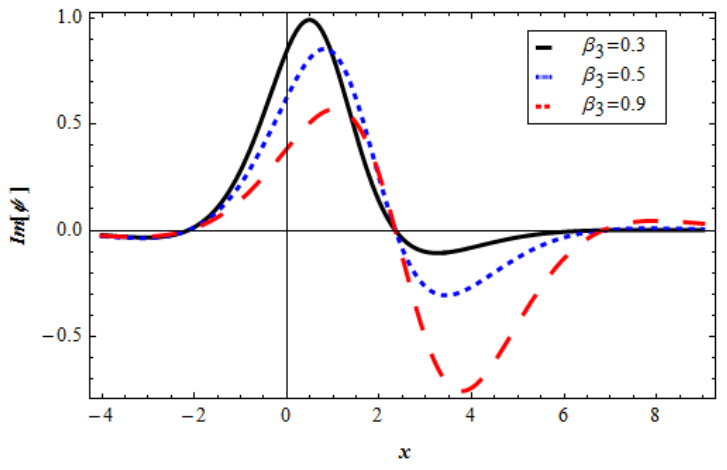
Figure 17. Change of solution (14) with z , t , β 3 for c = 0.5, v = 0.7, β 1 = 0.1, β 2 = 1, β 4 = 0.2.